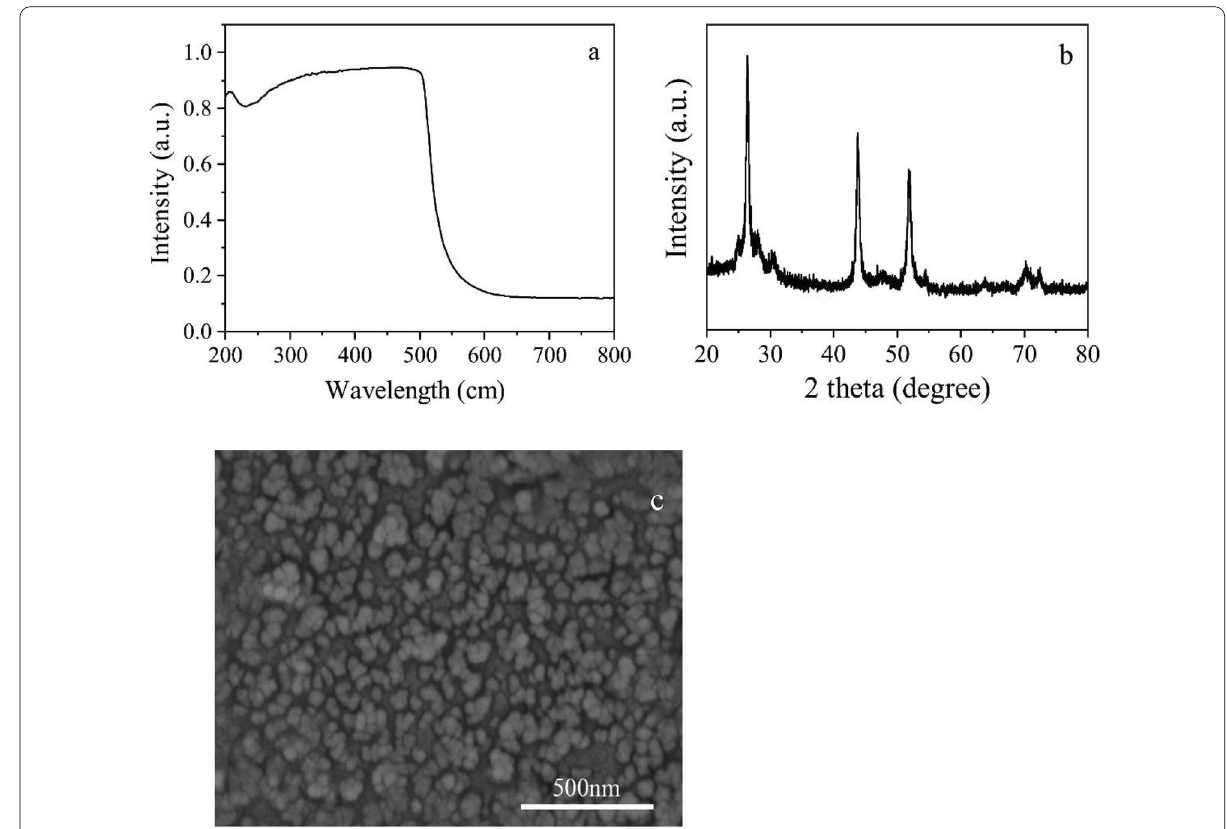
Fig. 1 The characteristic of CdS NPs ( a UV of CdS NPs; b XRD of CdS NPs; c SEM of CdS